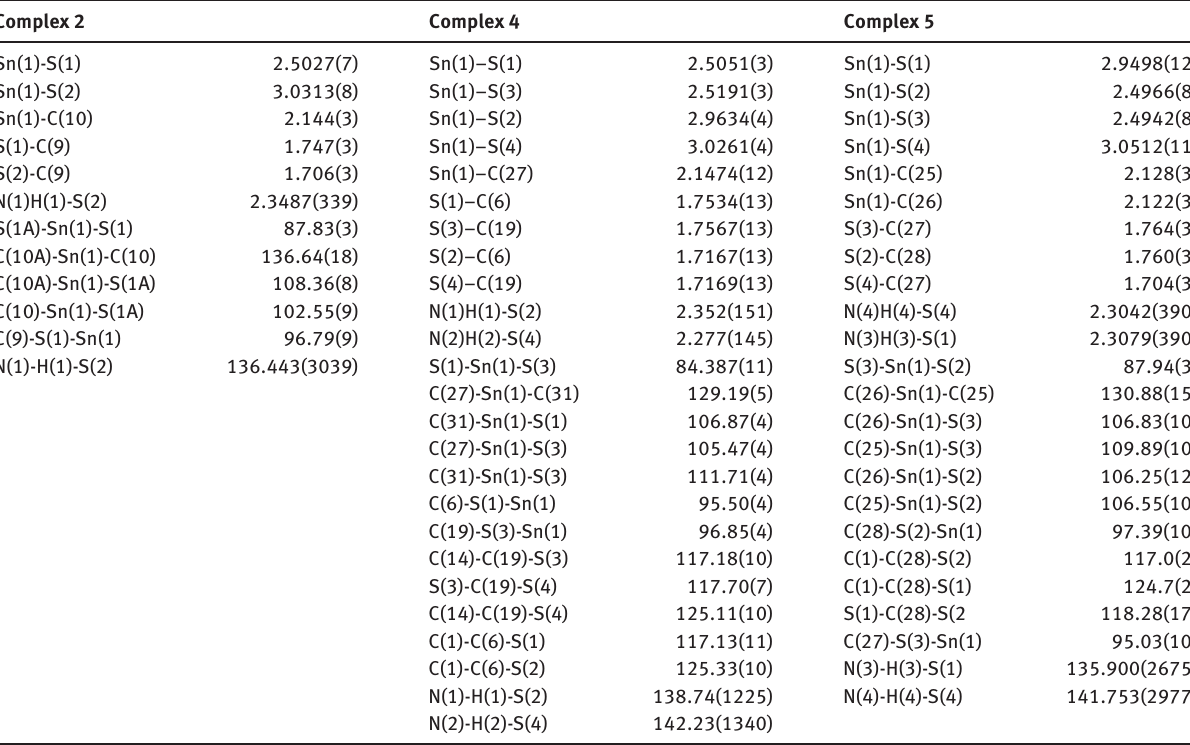
Table 2 Selected bond lengths (Å) and bond angles ( ° ) for complexes 2 , 4 and 5